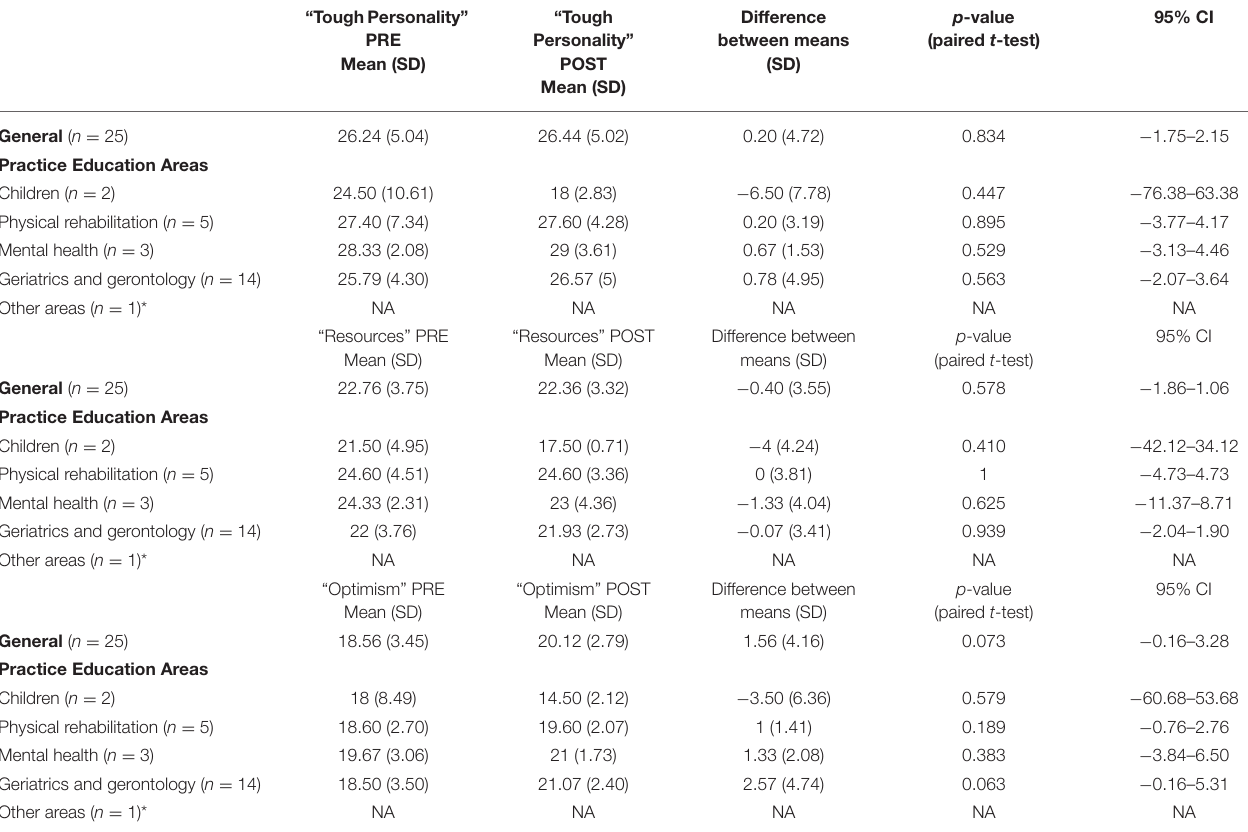
TABLE 6 | Practical training PRE-POST scores of dimensions “Tough Personality,” “Resources,” and “Optimism” (CD-RISC 25) in male students ( n = 25).